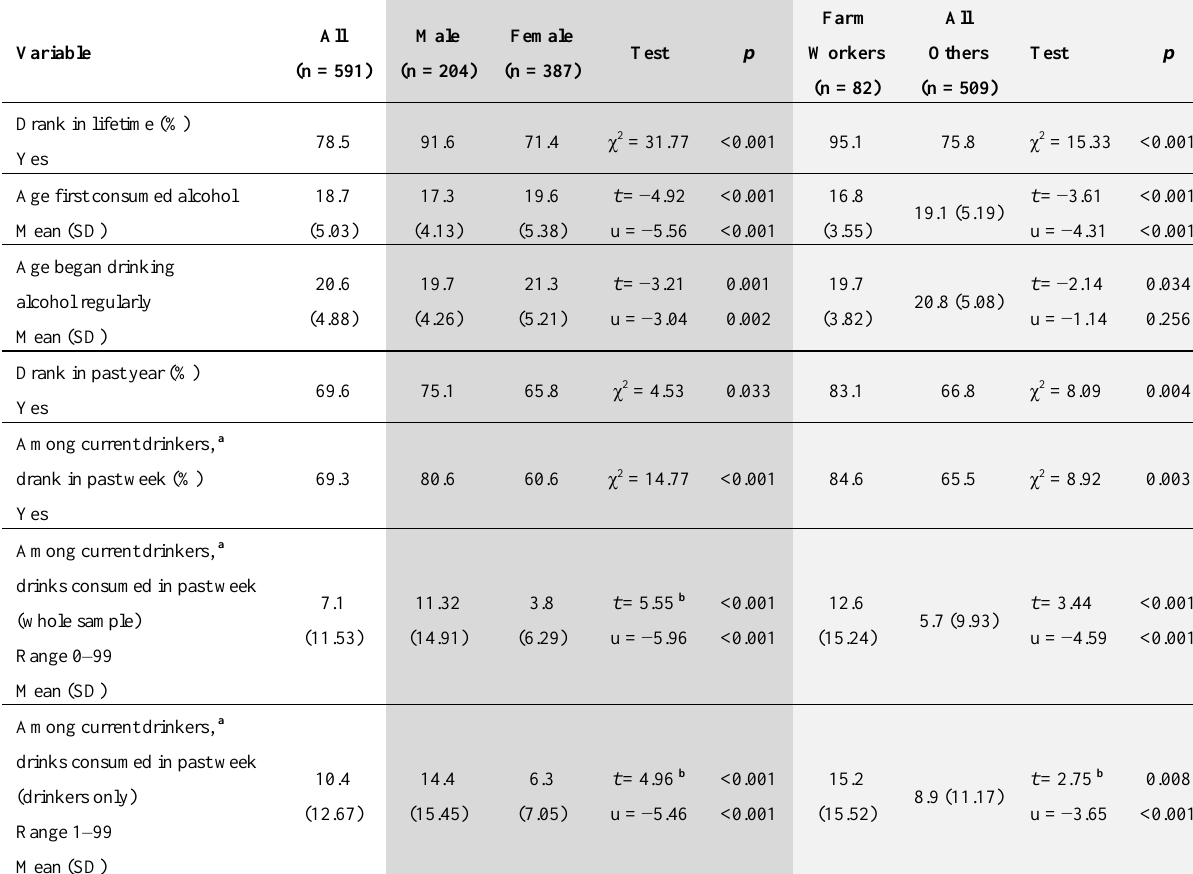
Table 2. Alcohol use by gender and occupation, Western Cape Province, South Africa: